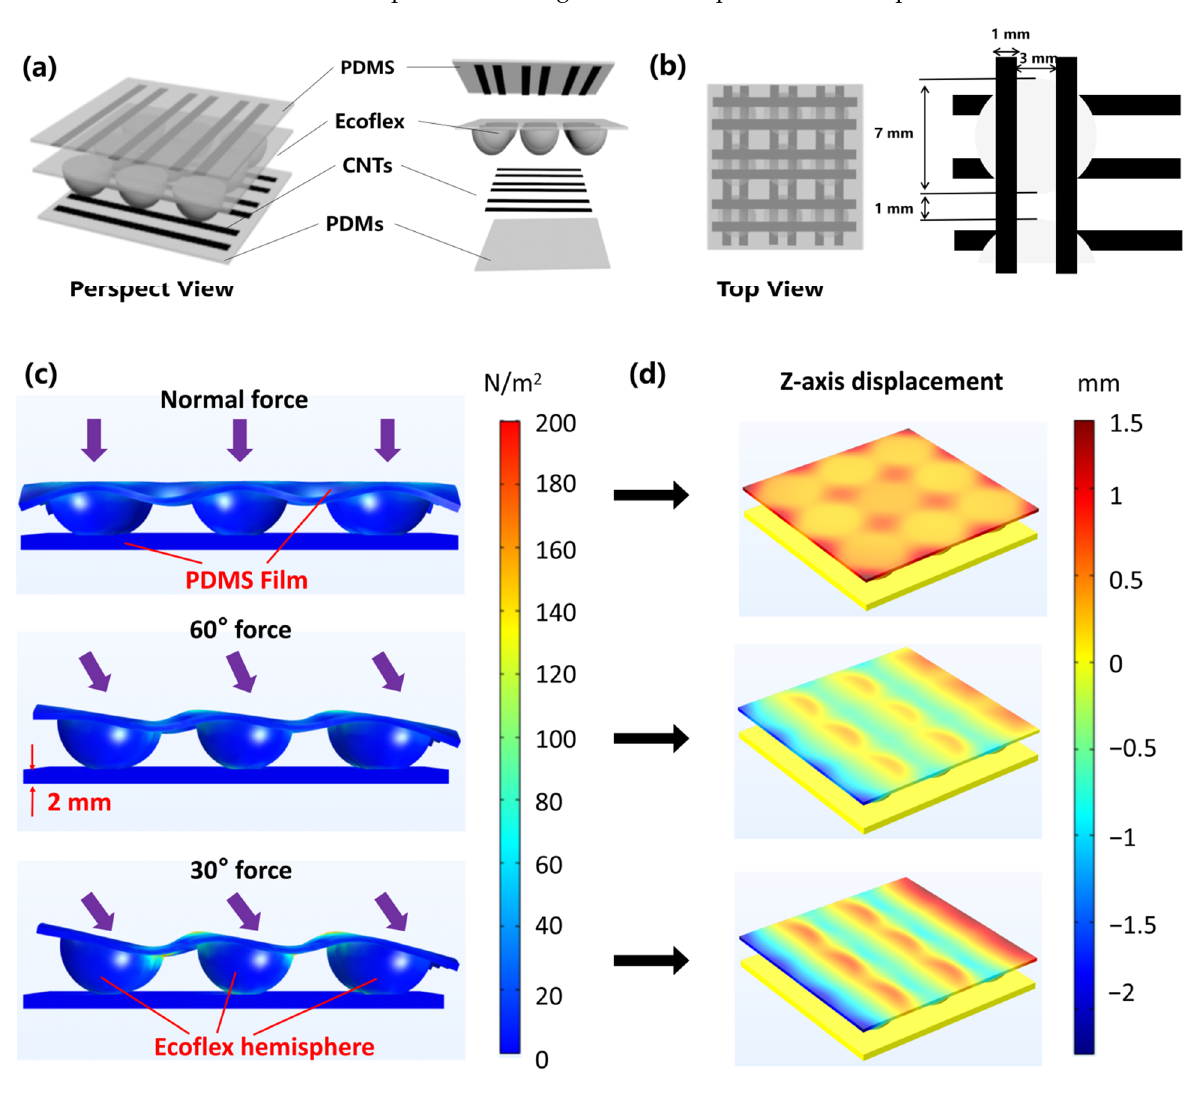
Figure 1. Flexible omnidirectional tactile sensors consisted of MWNTS/PDMS coated films and hemisphere array. ( a ) Schematic diagram of the sensor structure in perspective view, including upper and lower electrodes and the dielectric layer. ( b ) Top view of the sensor with the size marking. ( c ) Simulation schematic of the ODT sensor under different directions of 1N forces with the informative marking. ( d ) Simulation of the z-axis variable of electrode layer corresponding to different direction